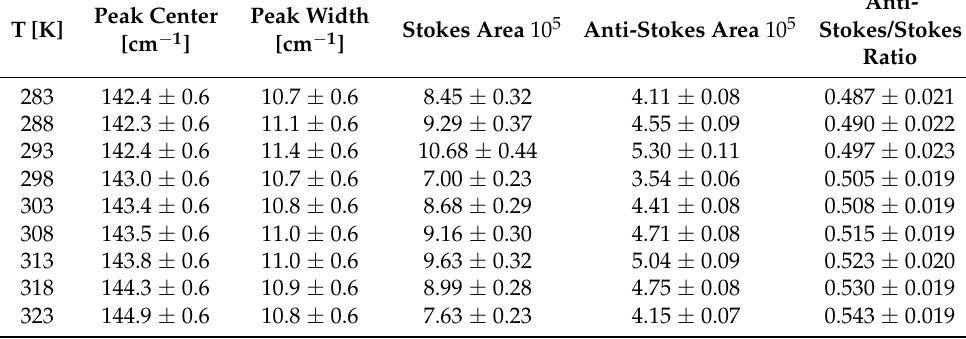
Table 2. Frequency position and width of the Stokes peak at 143 cm − 1 , Stokes and anti-Stokes areas and anti-Stokes/Stokes ratios for the temperature range 283–323 K, explored during the calibration procedure at 514.5 nm. T [K]